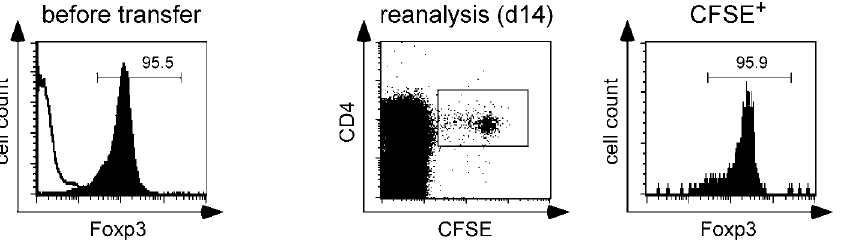
Figure 1. Stable Foxp3 Expression in CD25 þ CD4 þ Tregs CD25 þ CD4 þ Tregs were isolated ex vivo from pooled spleen and LN single-cell suspensions, labeled with CFSE, and then transferred into syngenic 8-wk- old recipients (2 3 10 6 /mouse). Before transfer, sorted cells were analyzed for intracellular Foxp3 expression by FACS. Fourteen days after transfer, splenocytes of recipient mice were stained for CD4, CD25, and Foxp3, and analyzed by FACS. About 0.1% of total splenocytes and, accordingly, 3% of total Foxp3 þ splenocytes were donor derived (CFSE þ ). Representative dot and histogram plots from four independently analyzed mice were selected. Numbers display frequency of cells within indicated populations. Comparable results were obtained for cells isolated from peripheral or mesenteric LNs (unpublished data). The bars in the left and right graphs indicate the marker gate for Foxp3 þ cells. The box in the middle graph indicates the region that was used to gate for CD4 þ CFSE þ cells. These gated cells (CFSE þ ) are depicted in the right graph.